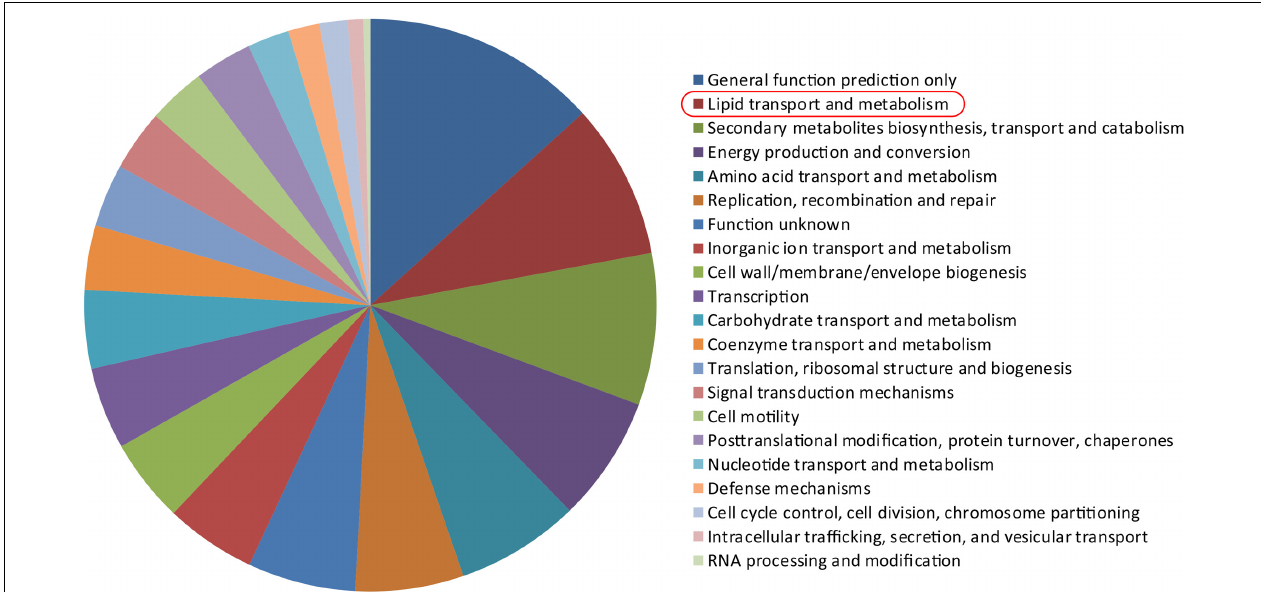
FIGURE 5 | Mtb RNAs detected in HC, LTBI, and ATB. We identified 2, 1 101, and 3 Mtb genes in HC, LTBI, and ATB samples, respectively. The pie plot on the right panel indicated Cluster of Orthologous Group (COG) analysis on the 1 101 Mtb genes in LTBI. A enrichment on COG category I “lipid transport and metabolism” was observed.